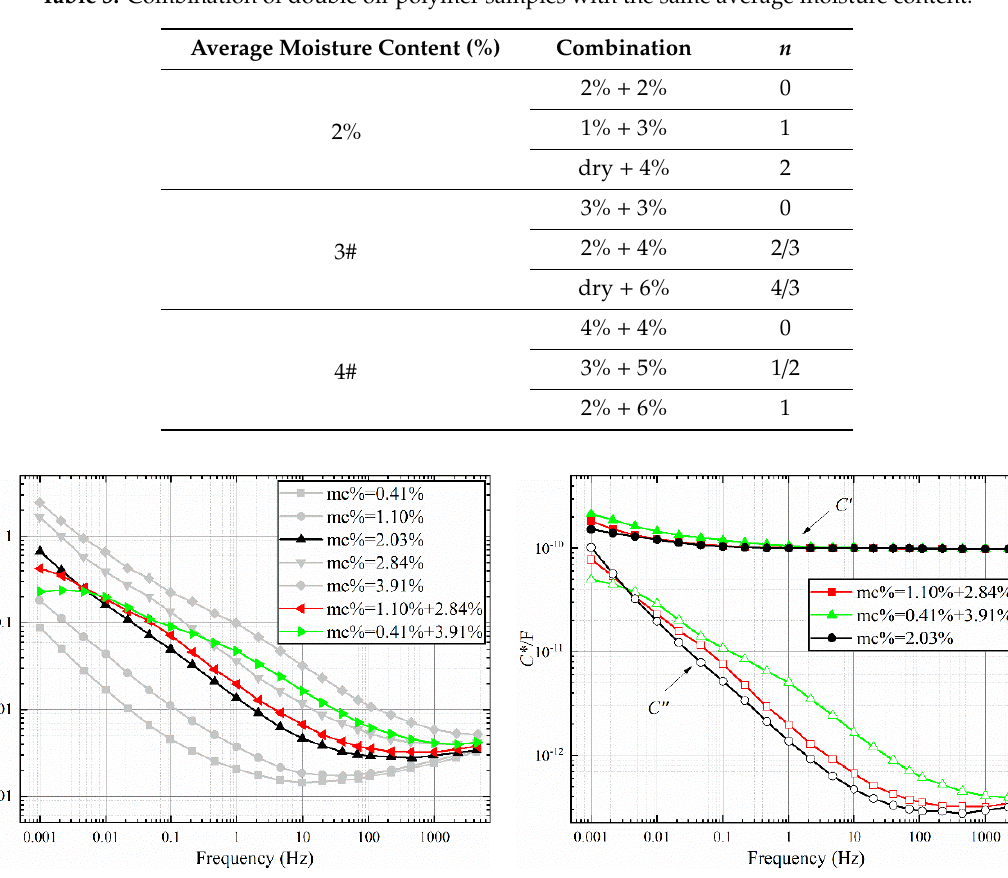
Table 3. Combination of double oil-polymer samples with the same average moisture content.